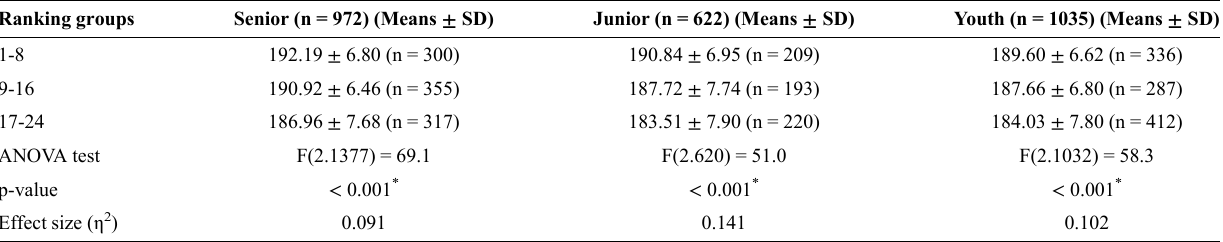
Table 2 - Descriptive (Mean ± SD) and comparative statistics of height (in cm) per 8 ranking positions in each age category. Between ranking groups ANOVA separately for each age categories. Ranking groups